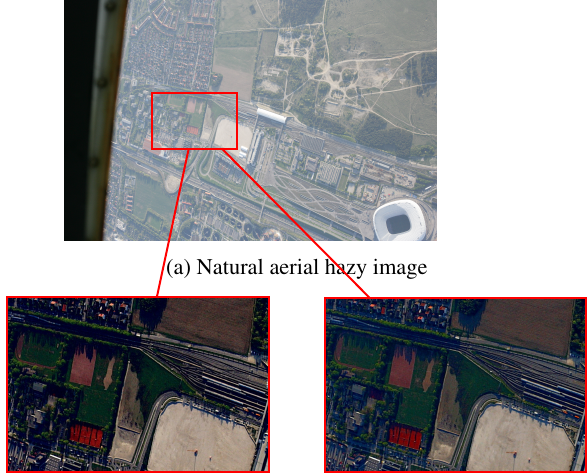
Figure 7: Dehazing natural hazy